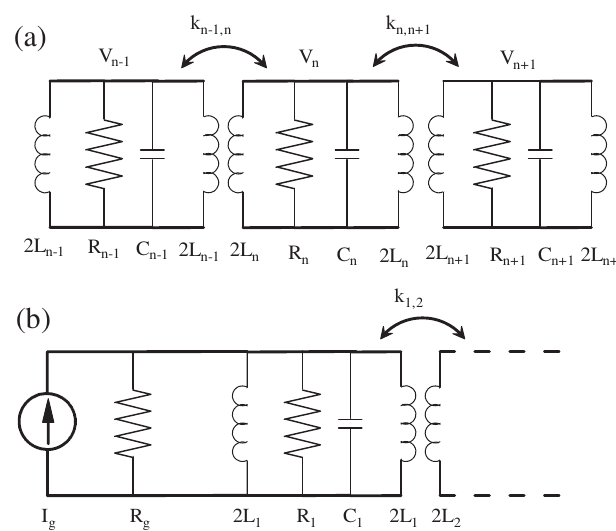
FIG. 2. General equivalent circuit model for a SW cavity powered from one end. Diagram (a) shows the regular cell equivalent circuit where k is the coupling coefficient between neighboring cells, and diagram (b) shows the input coupler cell and the power generator equivalent circuit, where R generator impedance.